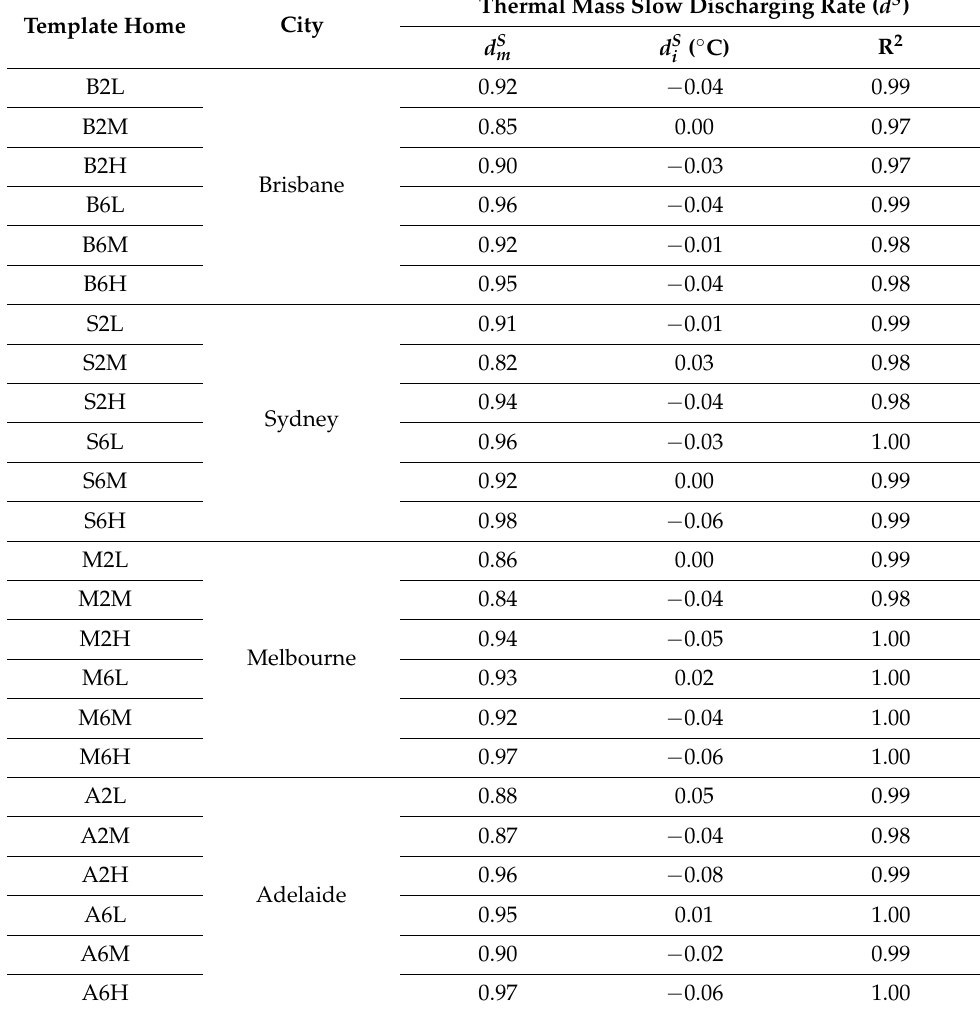
Table A5. Thermal mass slow discharging